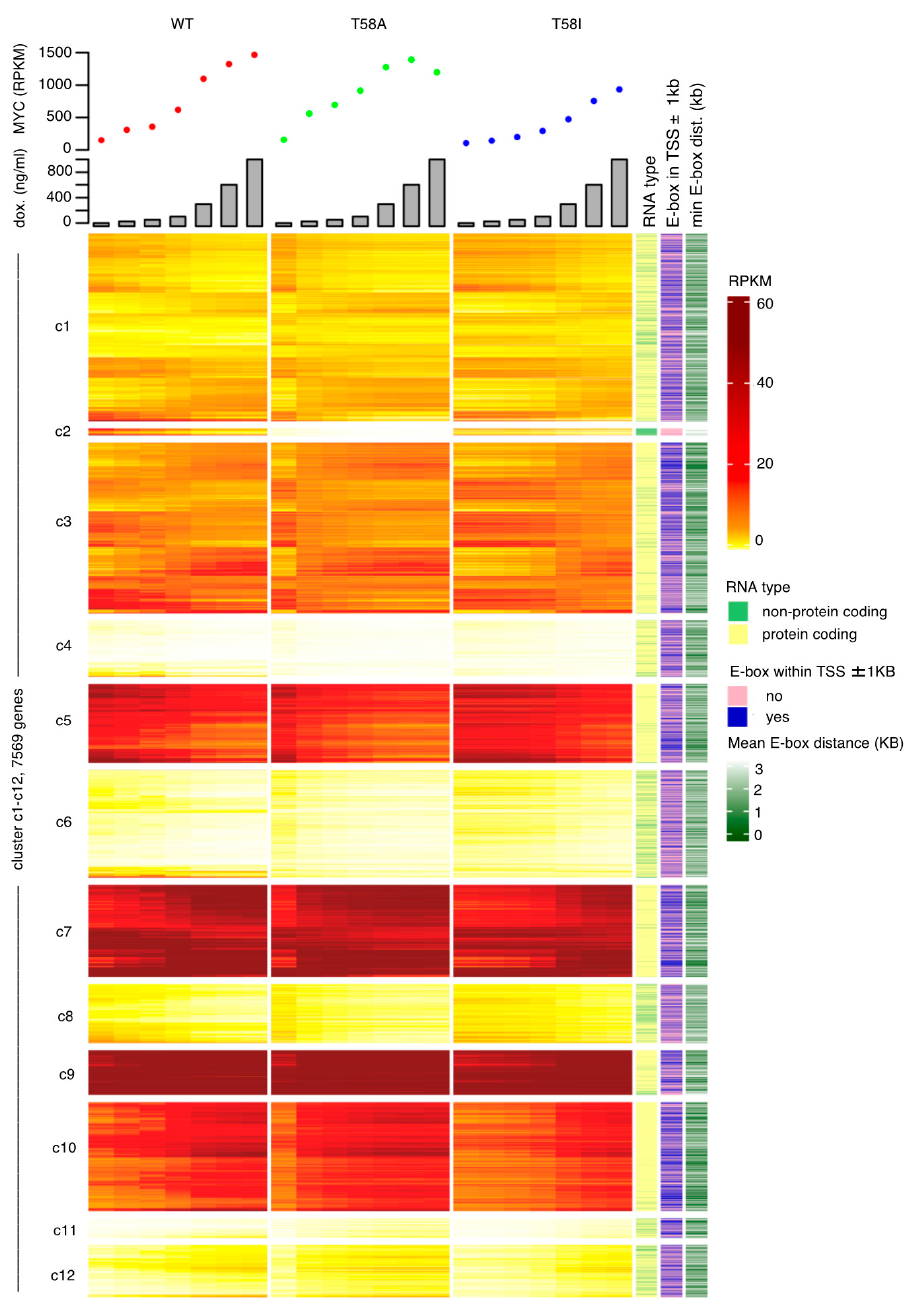
Figure 3. Expression levels for gene clusters. Hierarchical clustering based on expression levels for the union of genes that were either significantly changed upon increased MYC levels in WT or that were differentially regulated in response to increasing MYC levels between MYC WT and MYC T58A or between MYC WT and MYC T58I (7569 genes) yielded 12 clusters ( n = 3 independent experiments). The heatmap shows reads per kilobase per million of reads (RPKM) for all clustered genes (rows) for different levels (plotted above the heat map) of the three MYC genotypes (MYC WT (red dots), MYC T58A (green) and MYC T58I (blue), columns). Doxycycline concentrations (ng/mL) used to treat the cells are indicated by the bar-chart above the main heatmap. To the right of the main heatmap are three tracks describing, from left to right, whether the differentially regulated genes encode for protein-coding (yellow) or non-coding (light green) RNA, whether (blue) or not (pink) a gene has a canonical E-box motif within 1kb of its transcription start site (TSS), and the last track describes the distance between the TSS and the closest canonical E-box